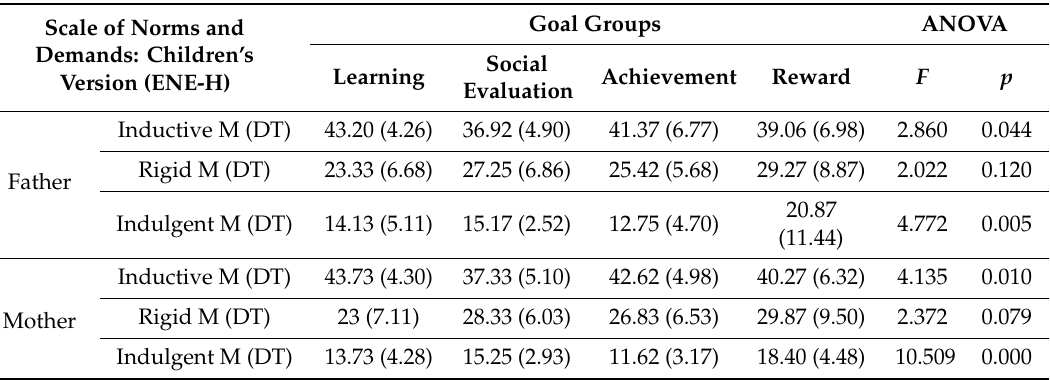
Table 3. Means and standard deviations for ENE-H factors with respect to the di ff erent goal groups into which the participants were